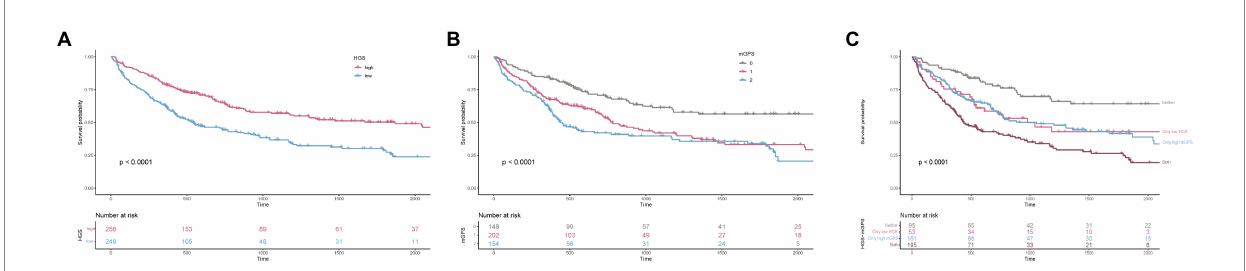
FIGURE 1 The Kaplan–Meier survival curves of HGS, mGPS, and HGS-mGPS. (A) HGS; (B) mGPS; (C) HGS-mGPS. HGS, hand grip strength; mGPS, modified Glasgow Prognosis Score.